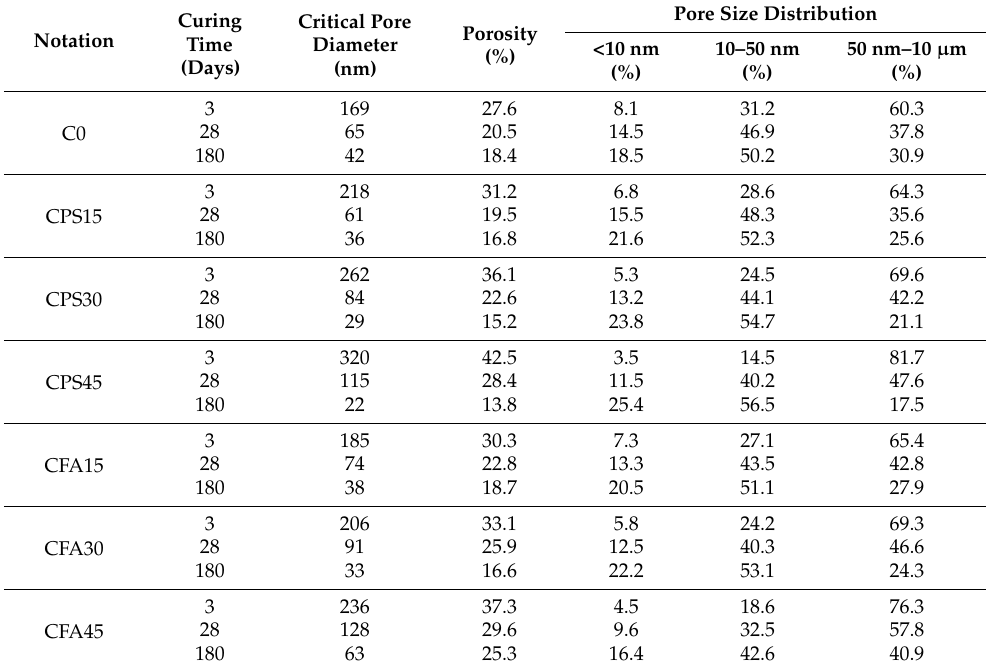
Table 4. Pore structures of hydraulic concretes added with FGPS and fly